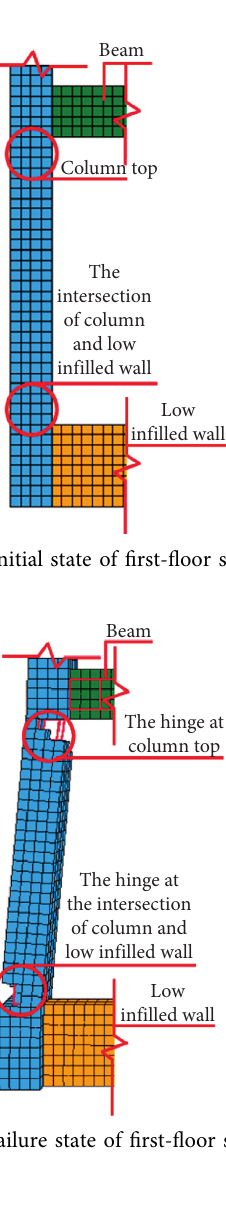
Figure 47: The collapse law of the numerical model of RC frame structure.